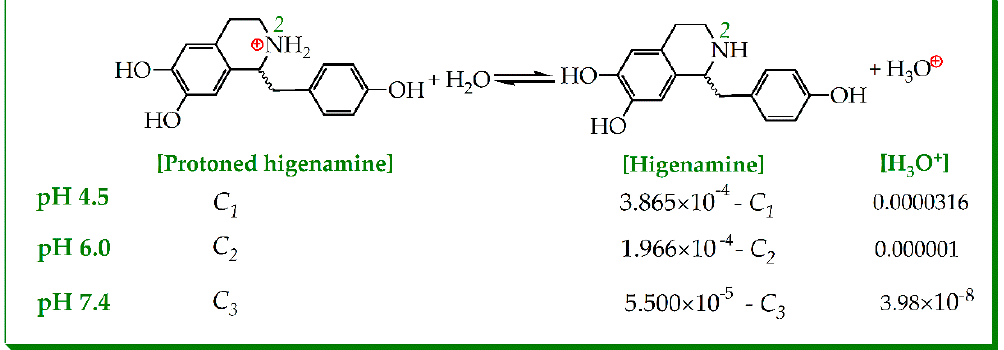
Figure 5. Ionization equilibrium of protonated higenamine (the total concentration of higenamine was adopted from its IC 50 values listed in Table S2).